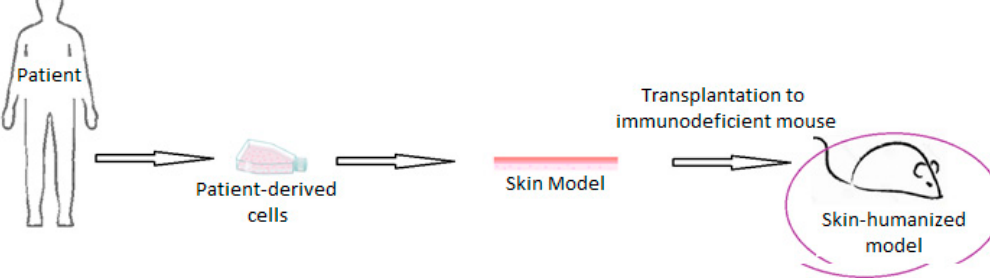
Figure 7. Generation of skin-humanized mouse model: cells are derived from patients or healthy donors, a skin equivalent is in vitro fabricated and cultivated, and then it is transplanted to an immunodeficient mouse.